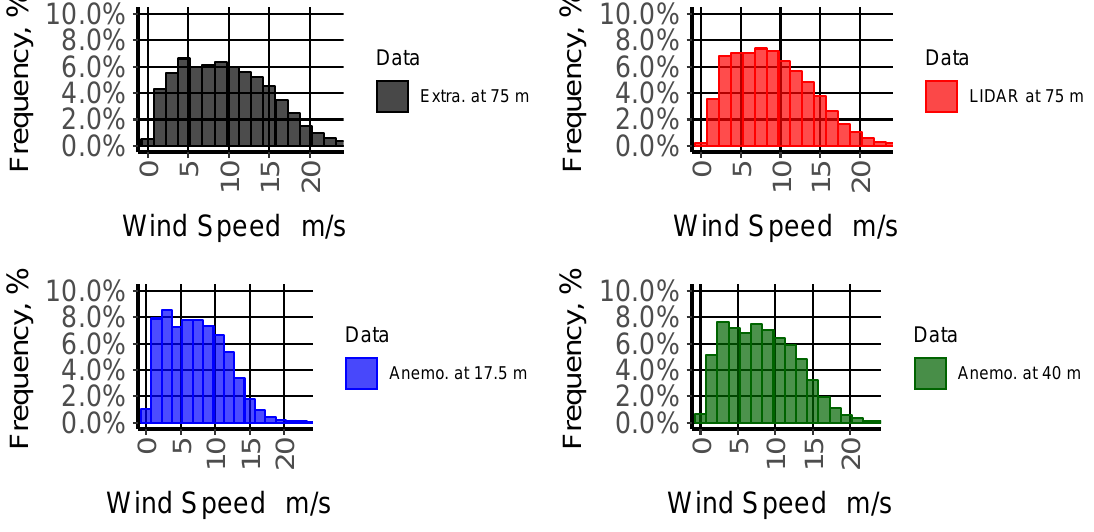
Figure 7. Wind speed frequency distributions from different data measurements and 75 m high extrapolated data at La Ventosa, Oaxaca,